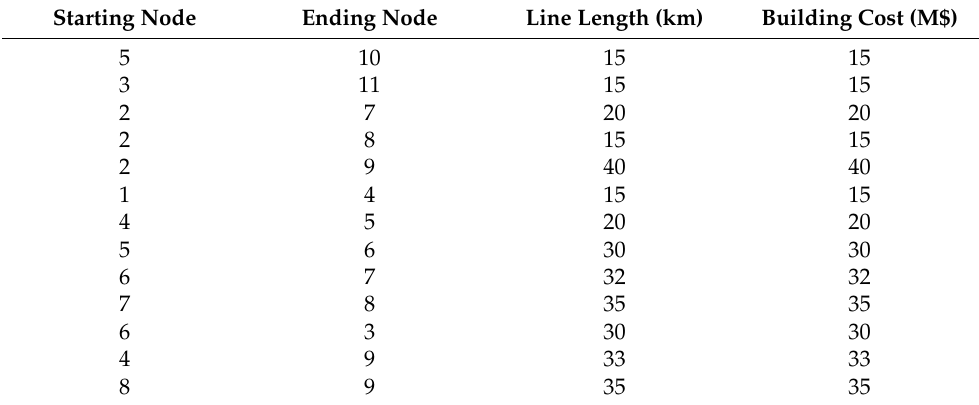
Table A5. Length and cost of lines to be selected in the power system. Reproduced from [30,33], IEEE Transactions on Power Systems: 2009 and Proceedings of the Chinese Society of Electrical Engineering: 2017.